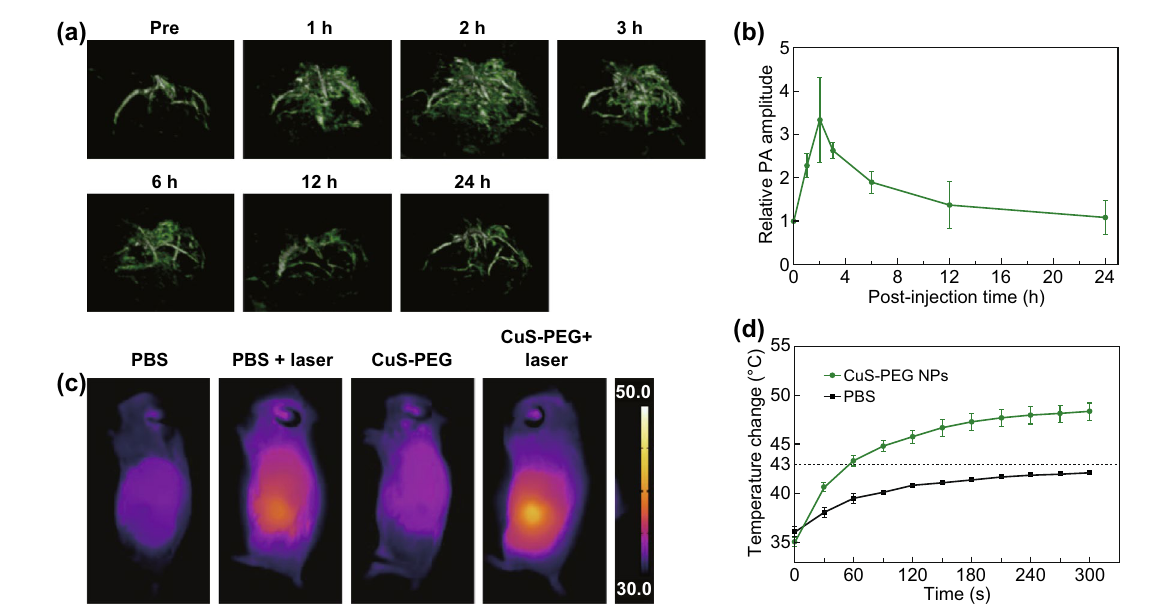
Fig. 6 PAI of tumors and PTT with 1275 nm laser. a Three-dimensional reconstructed PA images of the tumor site before and in different time points after intravenous injections of CuS-PEG NPs (200 μL, 2 mg mL −1 ) and b quantitative results of relative PA signals. c Infrared thermal images of 4T1 tumor-bearing mice after different treatments. d Tumor temperature as a function of laser irradiation time after intravenous injec- tion of CuS-PEG NPs (200 μL, 2 mg mL −1 ) or PBS (200 μL). The error bars represent standard deviations ( n = 3 per group)